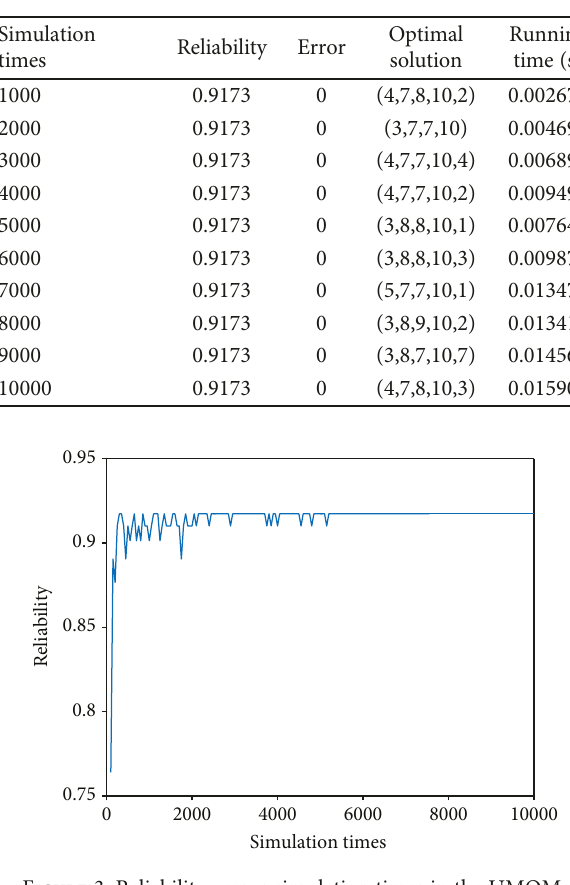
Table 3: Simulation results with a step size of 1000 in the UMOM.